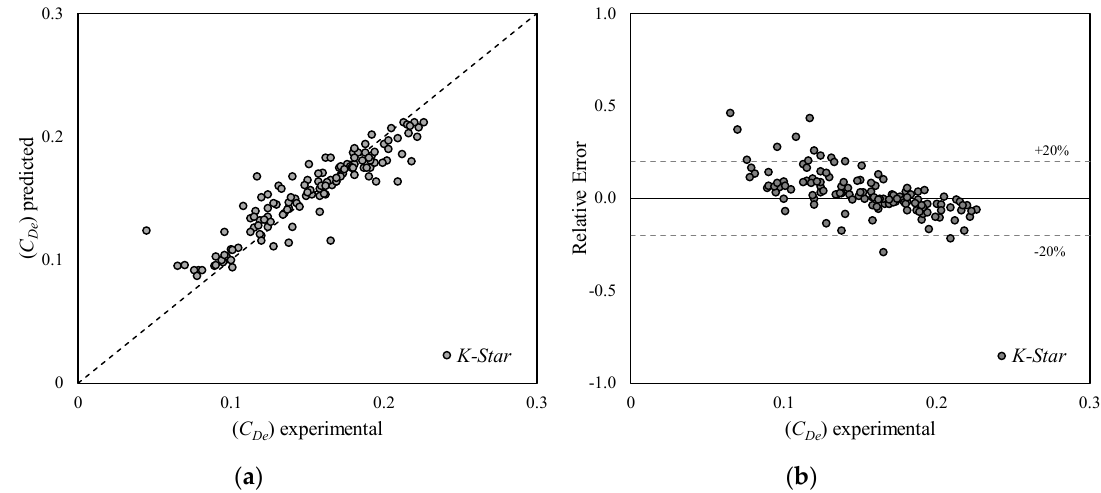
Figure 10. Model 2, K-Star algorithm, ( a ) predicted versus experimental results, and ( b ) relative error versus experimental results.